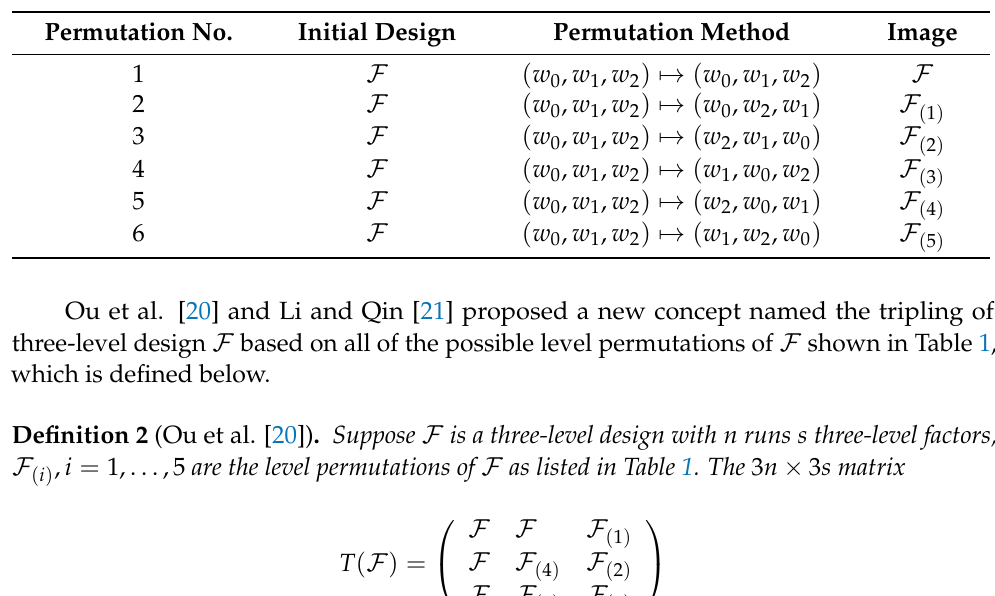
Table 1. All possible level permutations of design F